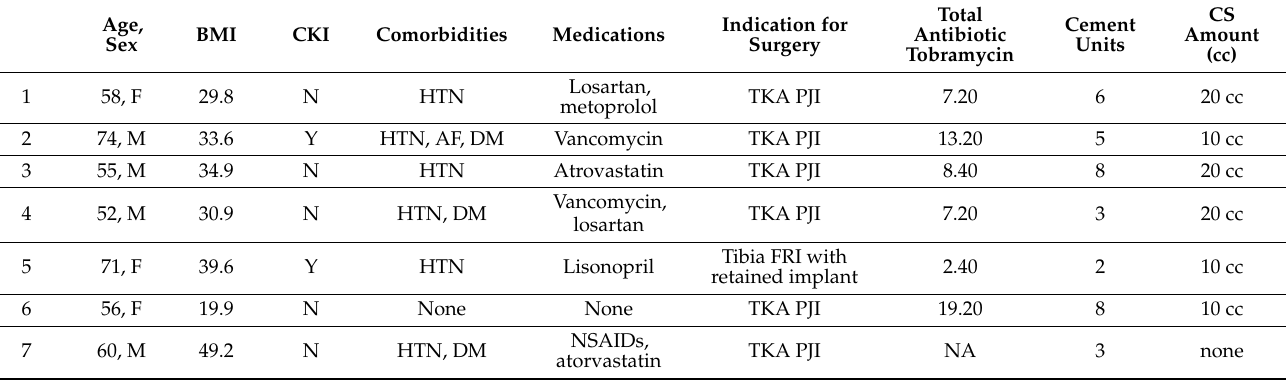
Table 5. Acute kidney injury